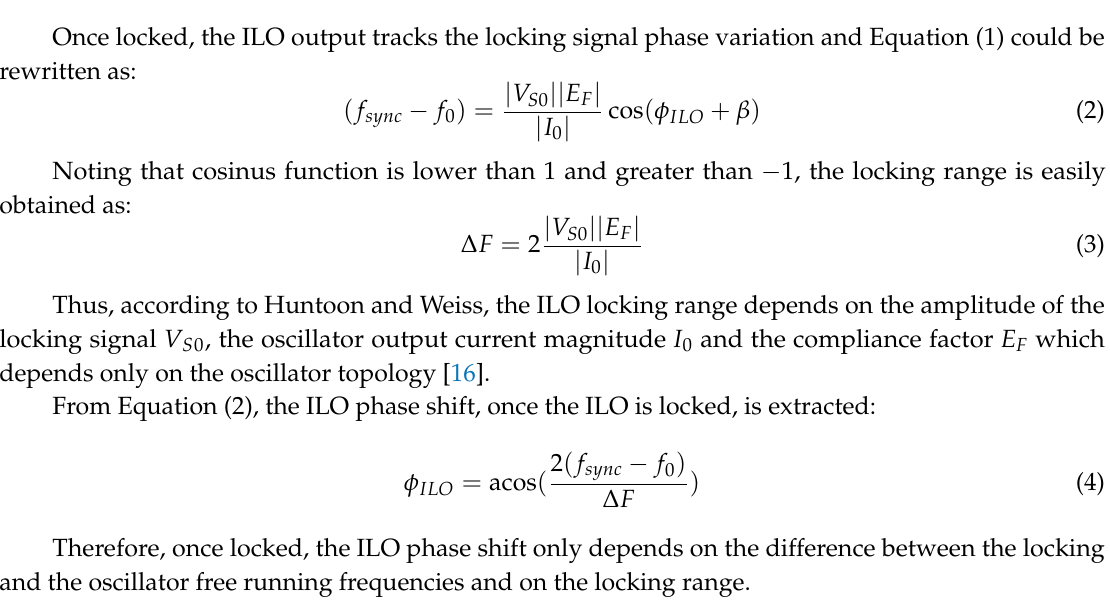
Figure 1. Property of Injection Locked Oscillators